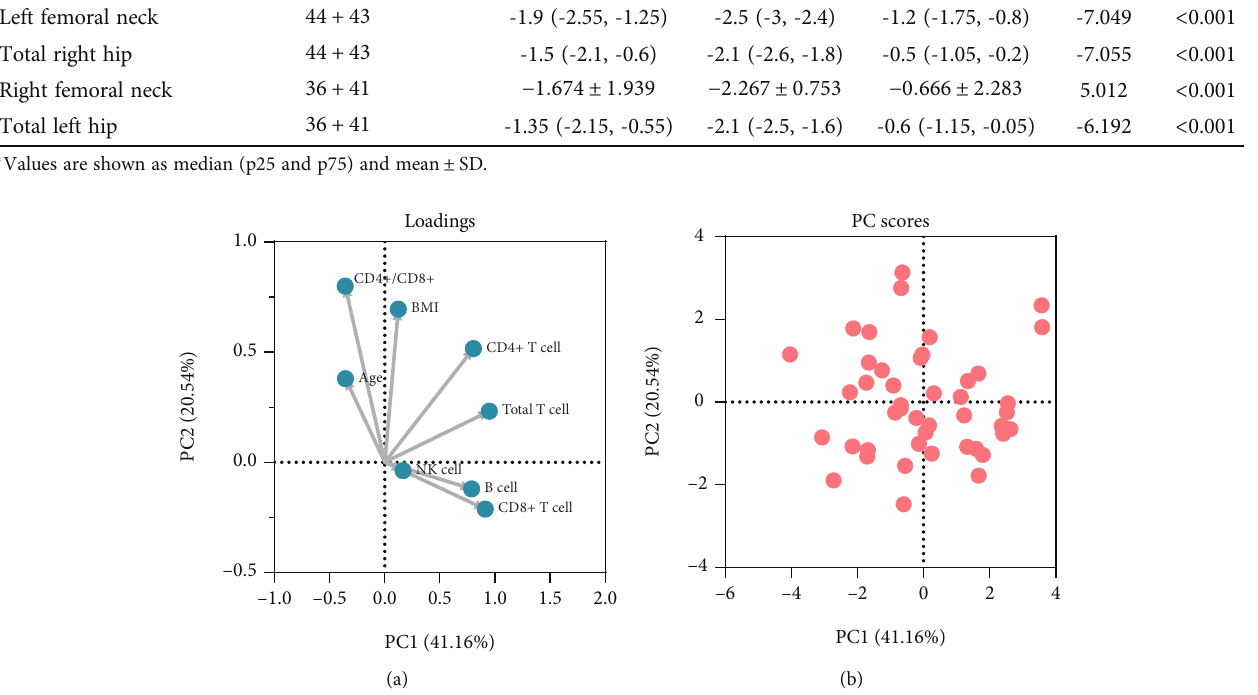
Groups ∗ U value P value OP